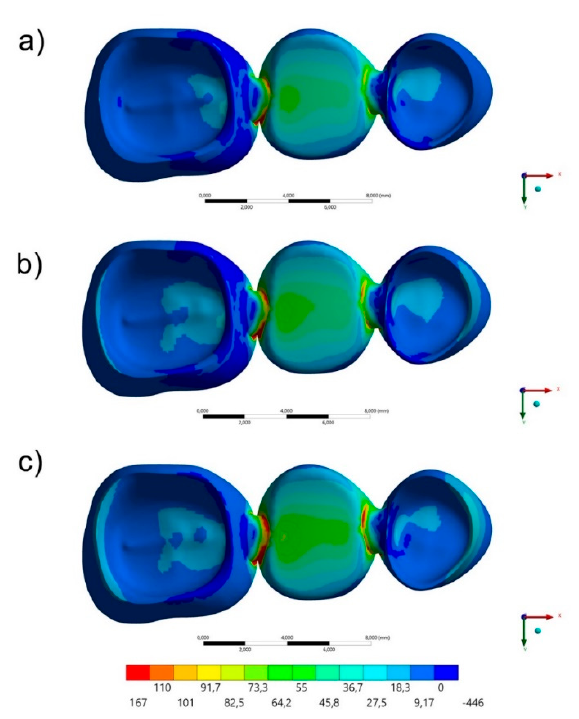
Figure 6. Bottom view of the Maximum principal stress maps in the FDP for each group: ( a ) AR, ( b ) PEEK and ( c ) RC. Table 2. Stress peaks (MPa) generated in the FDP and cement layers for each abutment tooth ac- cording to the evaluated restorative materials.